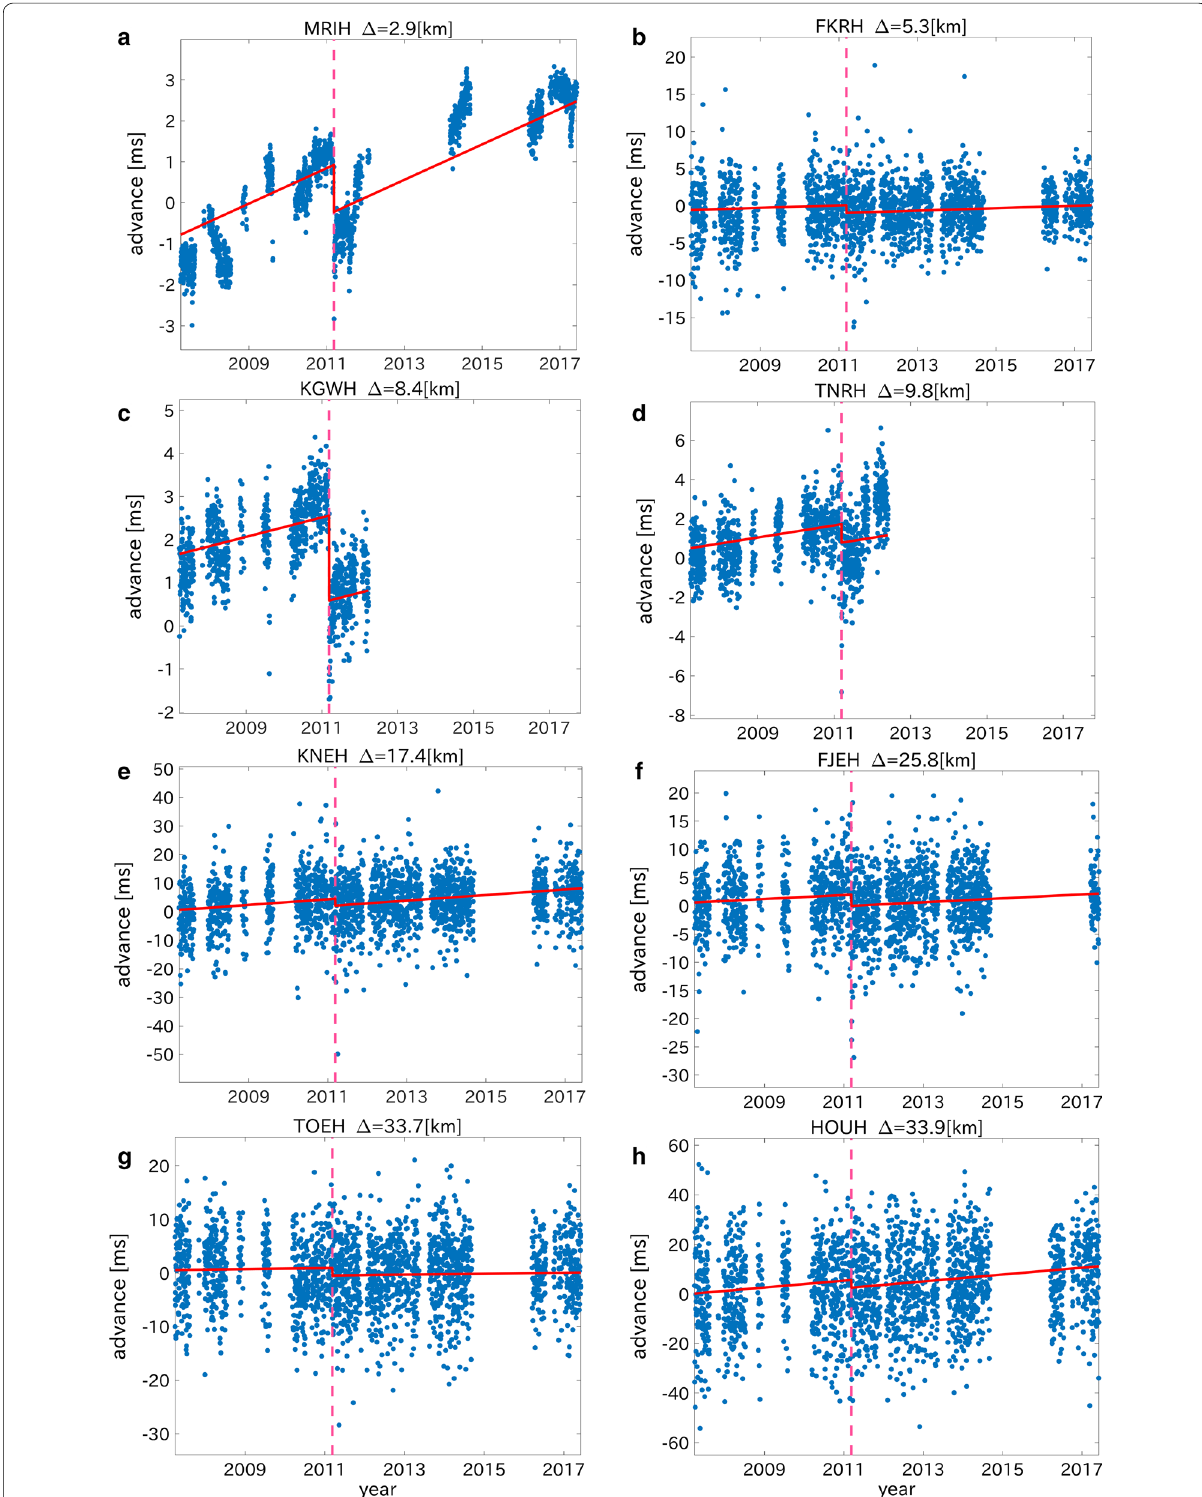
Fig. 3 Travel time deviations at eight representative stations. Blue dots show daily deviation of travel time, and red solid lines show estimated travel time deviation with our model. The broken lines show the time of the 2011 Tohoku